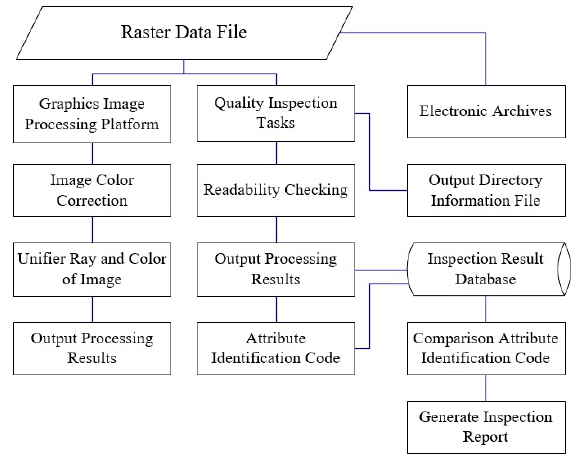
Figure 2 . The quality inspection process of raster